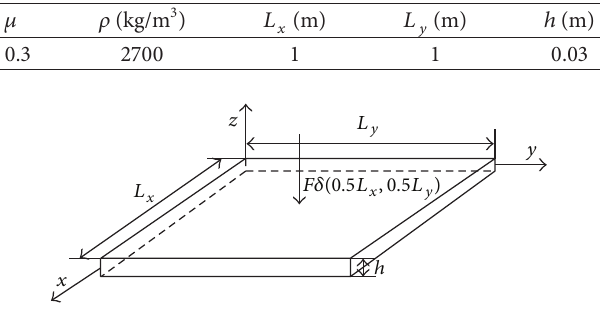
Table 1: Geometric parameters and material properties of the plate.